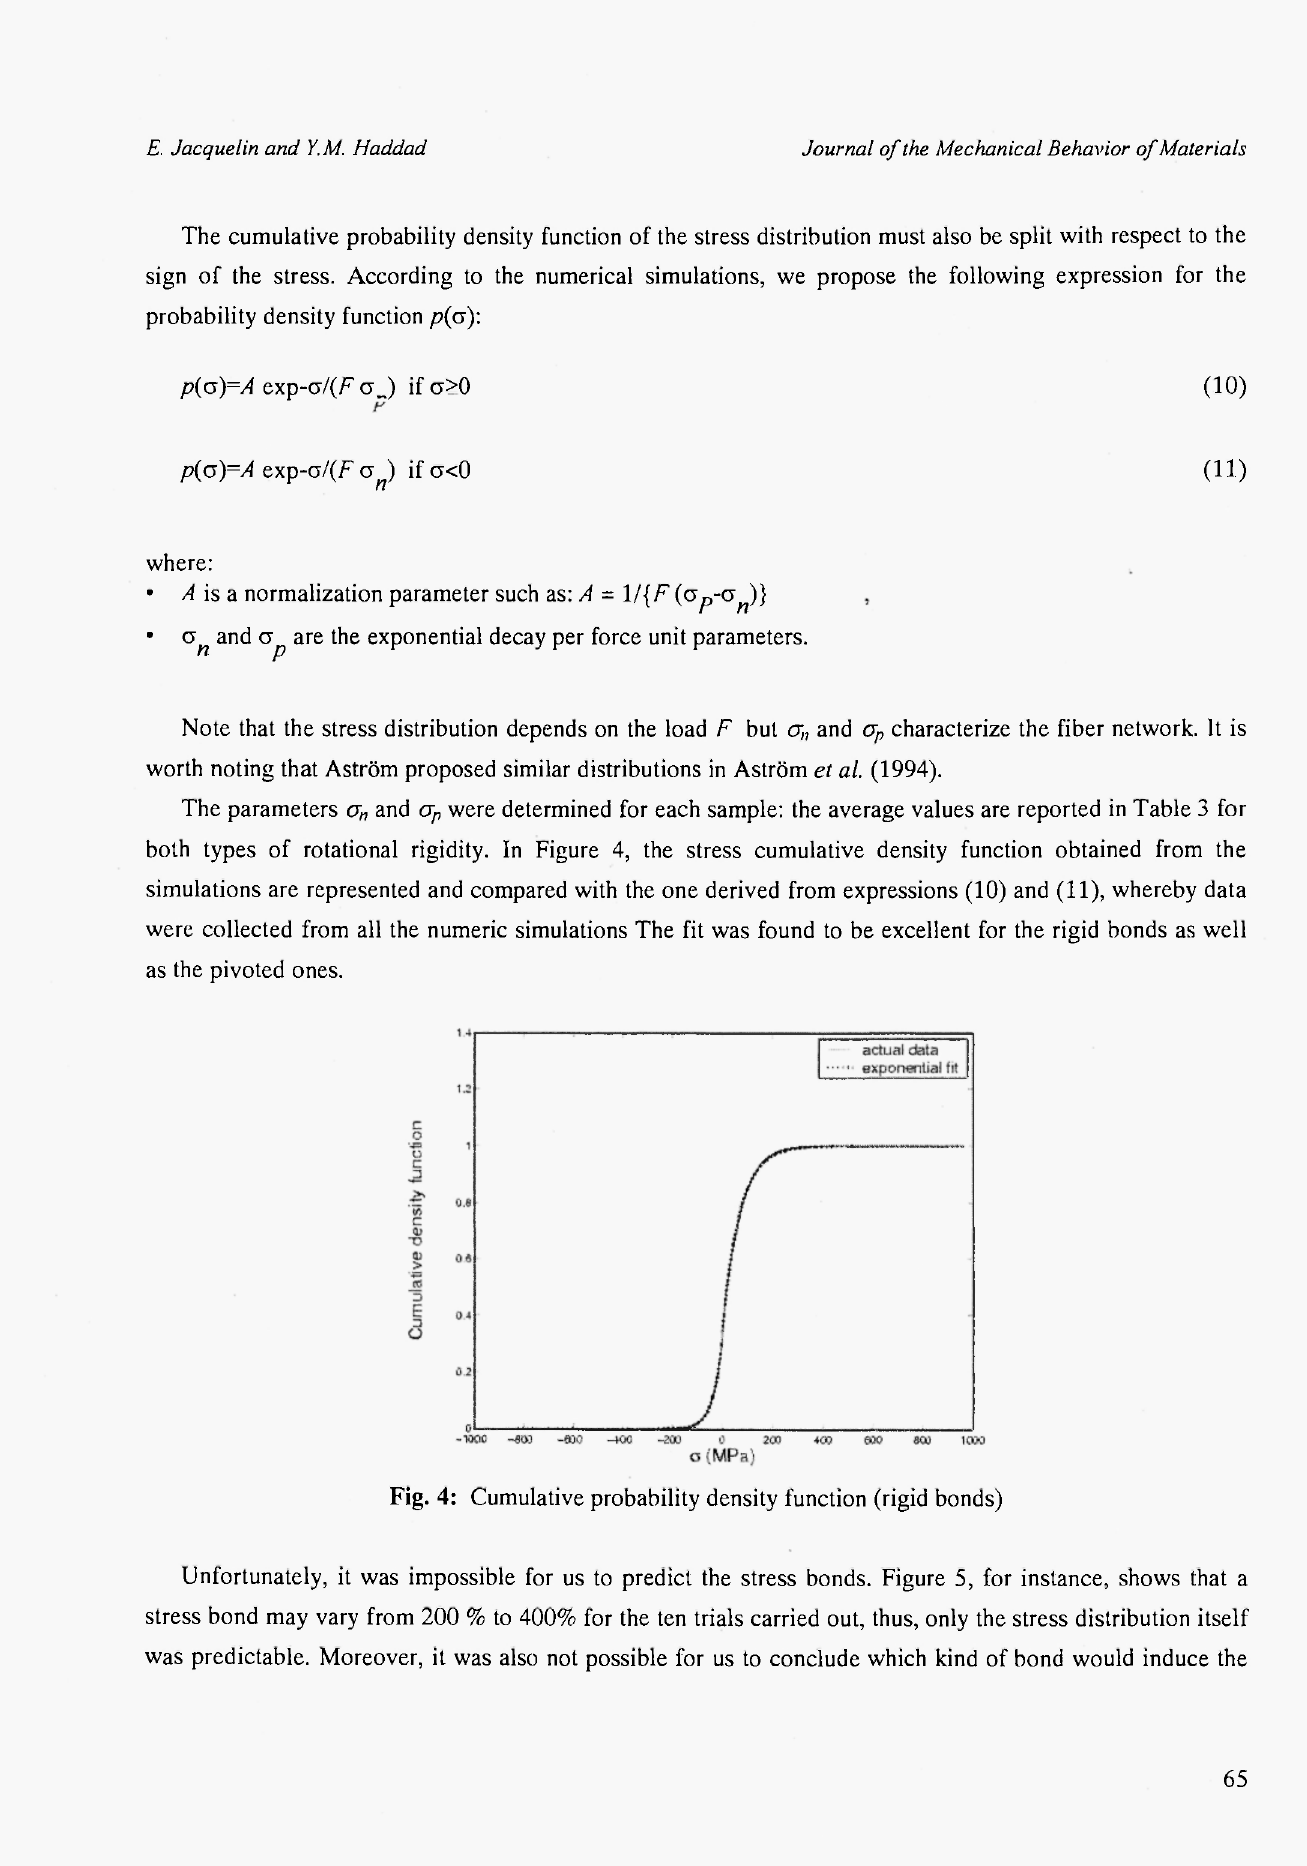
Fig. 4: Cumulative probability density function (rigid